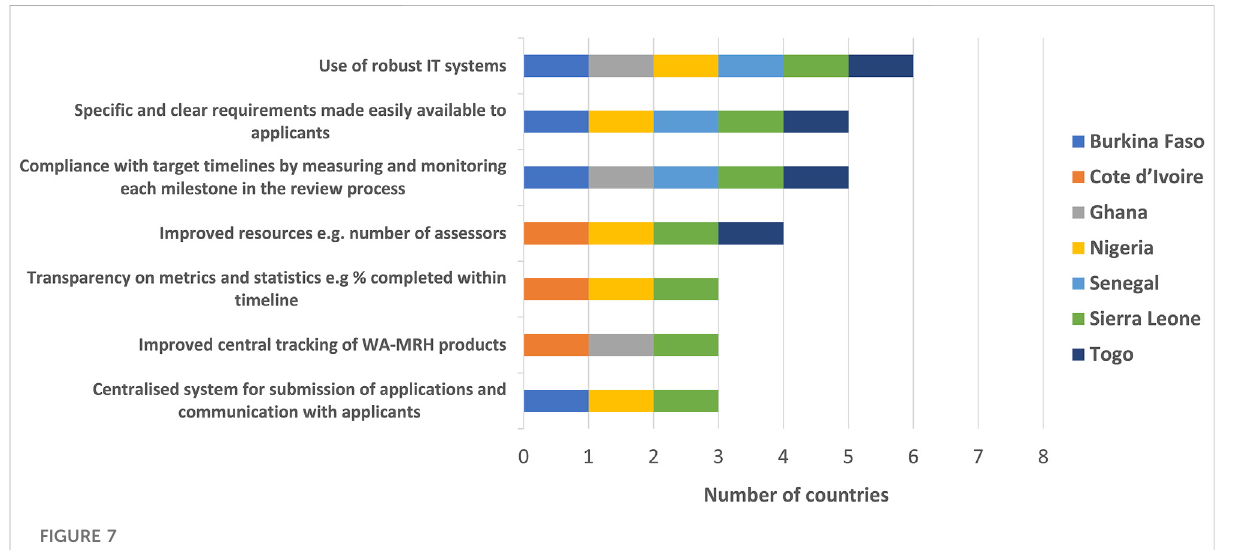
FIGURE 7 Ways to improve ef fi ciency of the WA-MRH